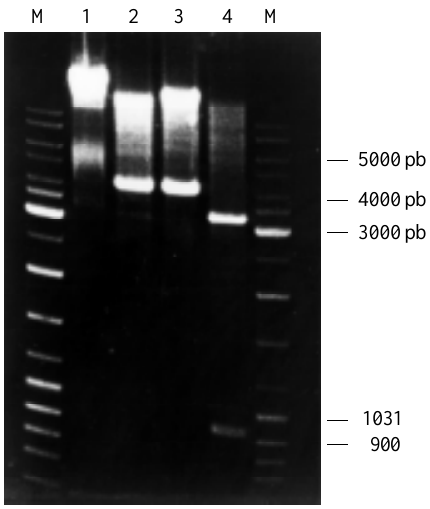
Figure 1 - Agarose gel electrophoresis of restricted recombinant plasmids. One representative colony Xl 1-blue transformed with pcDNA3-VHL was cultured in LB-medium overnight and plasmids were recovered as described above. Restriction was performed using 1 m l ( » 200 ng) plasmid DNA, and 10 U enzyme, each, for 1 h at 37 o C in a final volume of 10 m l, and then subjected to electrophoresis. M , Gene Ruler TM -DNA Ladder (MBI Fermentas, St. Leon- Rot, Germany). Lane 1 , Unrestricted DNA; lane 2 , Eco R1 restricted DNA; lane 3 , Bam H1 restricted DNA; lane 4 , Eco R1/ Bam H1 restricted